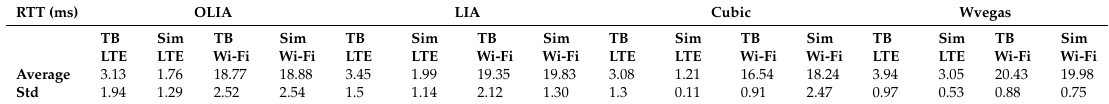
Figure 14. Setup 2 uplink MPTCP RTT for 75 MB flows. Table 6. Setup 2 uplink RTT for 75 MB data